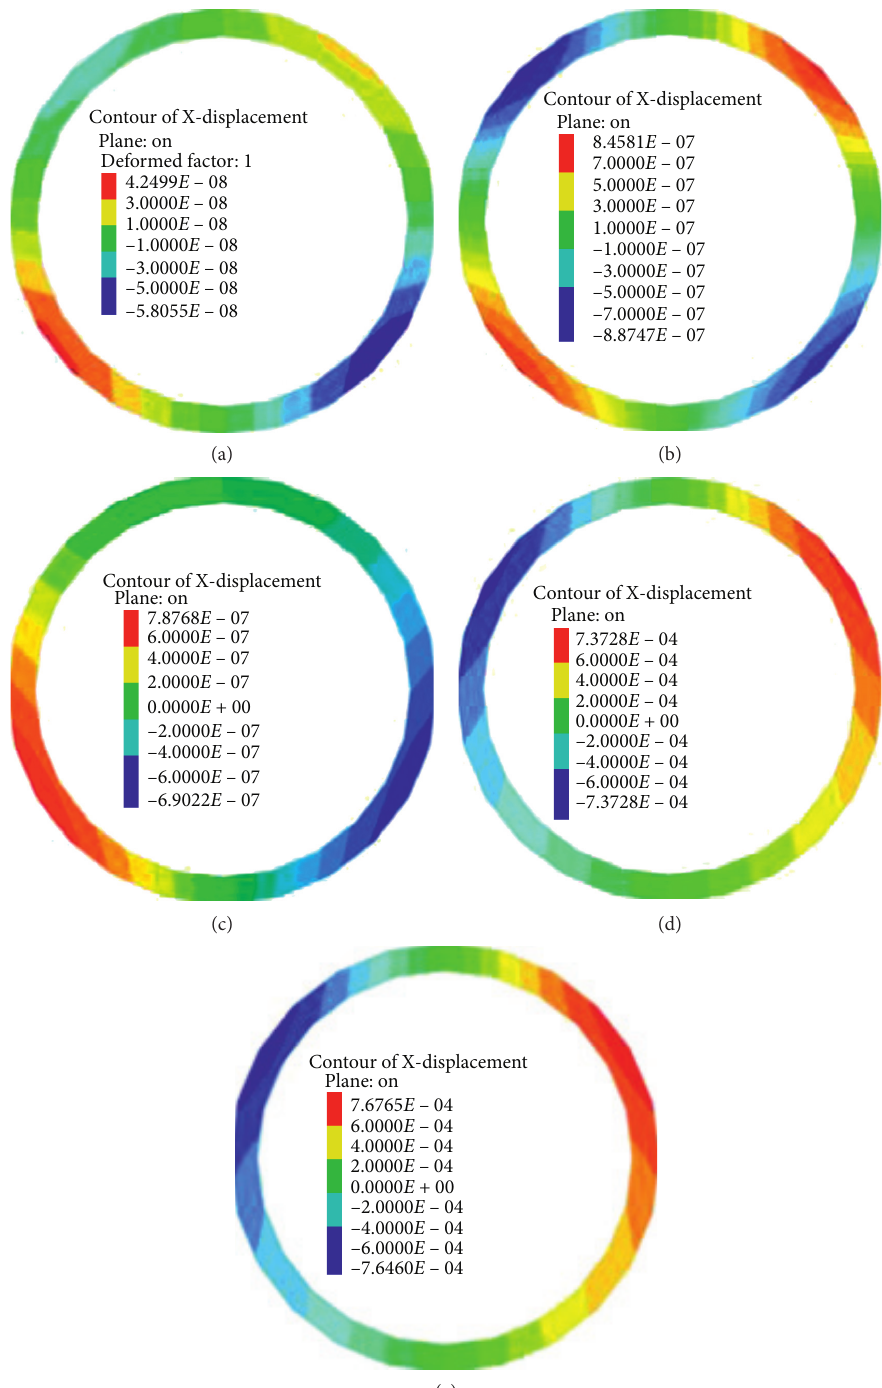
Figure 5: Cloud chart of radial distribution along displacement horizontal section, z � 23.5m from the bottom (unit: m). (a) λ � 0.6. (b) λ � 0.8. (c) λ � 1.0. (d) λ � 1.2. (e) λ �